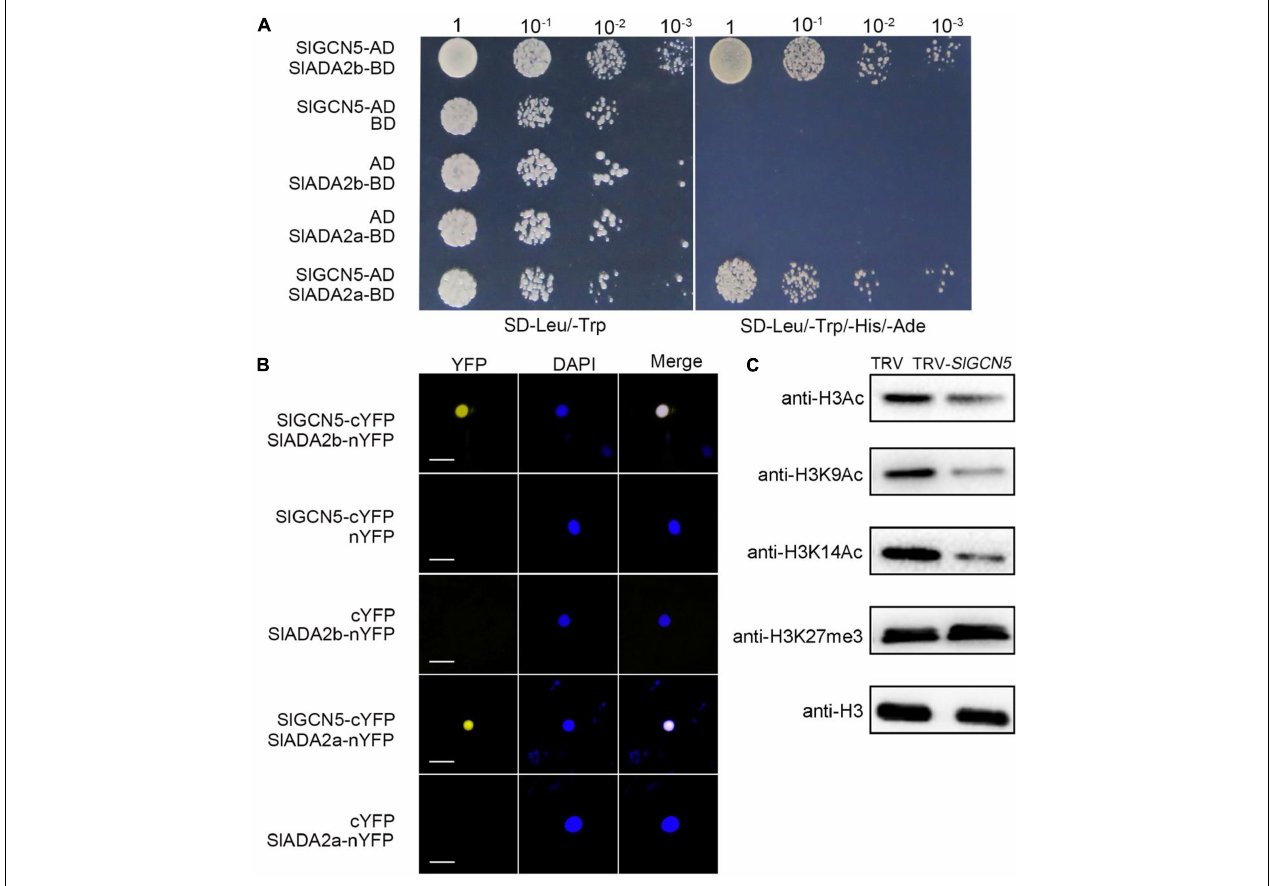
FIGURE 3 | SlGCN5 functions as a histone H3 acetyltransferase. (A) Yeast two-hybrid assays of SlGCN5, SlADA2a, and SlADA2b. Full-length cDNAs of SlGCN5 , SlADA2a, and SlADA2b were cloned into AD (the prey plasmid pGADT7) and BD (the bait plasmid pGBKT7), respectively. Yeast cells transformed with the indicated plasmids were grown on medium lacking leucine and tryptophan (SD/-Leu/-Trp) and selective medium lacking leucine, tryptophan, histidine, and adenine (SD/-Leu/-Trp/-His/-Ade). (B) Bimolecular fluorescent complementation analysis in tobacco leaves. Merge refers to merged images for yellow fluorescent protein (YFP) and DAPI fluorescence. SlGCN5 and SlADA2a/b were fused to cCFP and nYFP, respectively. Scale bars = 20 µ m. (C) Histone acetyltransferase activity of SlGCN5 determined by in vivo histone acetyltransferase assay. Histone acetylation levels were detected by immunoblotting with antibodies of the indicated histone acetylation marks in TRV and TRV- SlGCN5 plants. Anti-H3 antibody was used as loading